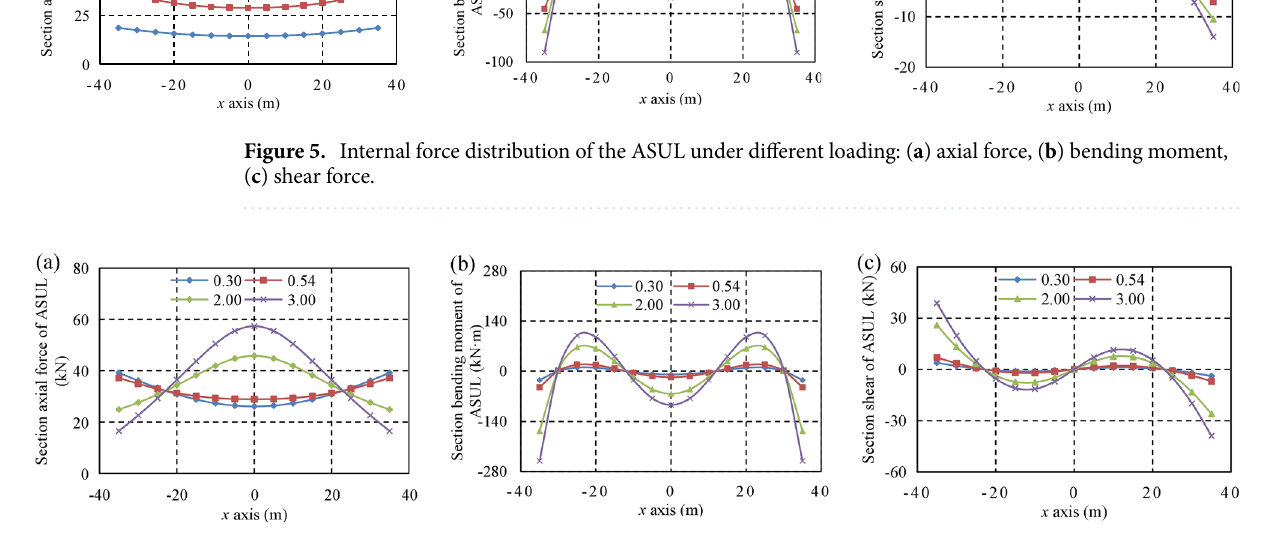
Figure 6. Internal force distribution of the ASUL under different horizontal pressure coefficients: ( a ) axial force, ( b ) bending moment, ( c ) shear force.